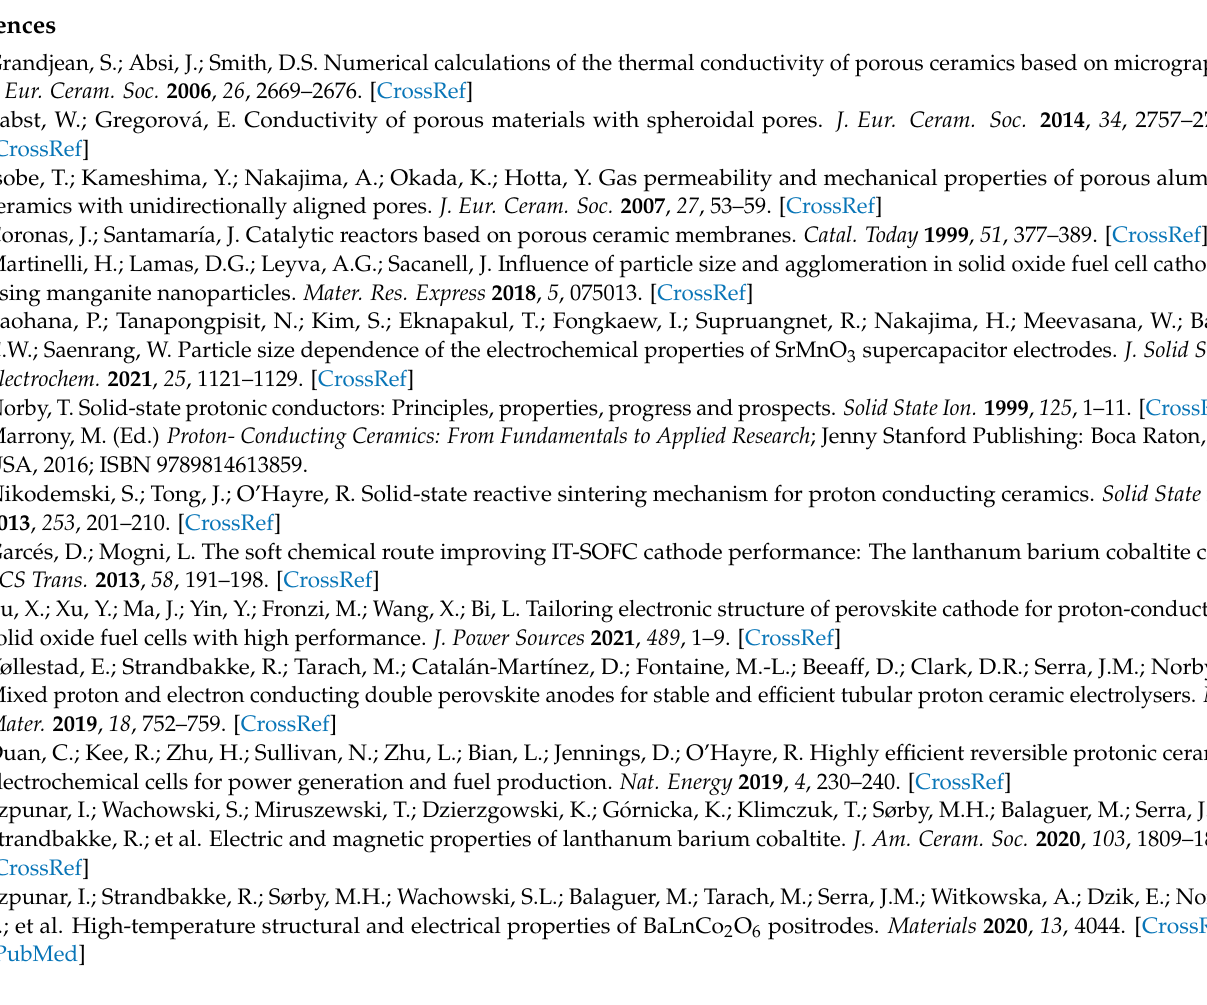
precursors with different ball milling parameters. Figure S2: The XRD data of BLCF synthesized sample after pelletizing pressure change investigation. Figure S3: The XRD data of BLCF synthesized during investigation effect of annealing parameters change. and Figure S4: The XRD data of BLCF synthesized during investigation effect of ball milling of